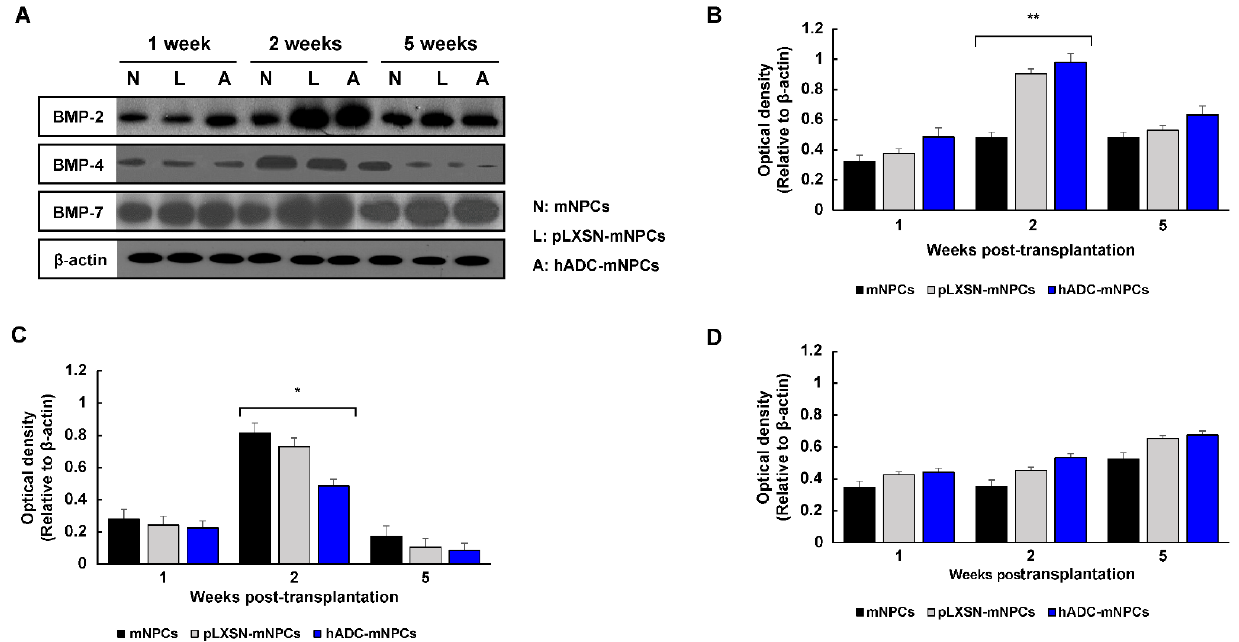
Figure 6. Western blot analysis of BMP-2, BMP-4, BMP-7, and β-actin from T8, T9, and T10 at 1, 2, and 5 weeks after cell transplantation. ( A ) Representative Western blots of BMP-2, BMP-4, BMP-7, and β-actin. ( B ) Quantification of BMP-2 showing a significant increase in hADC-mNPC mice compared with pLXSN-mNPC and mNPC mice at 2 weeks post-transplantation. ( C ) Quantification of BMP-4 showing a significant decrease in hADC-mNPC mice compared with pLXSN-mNPC and mNPC mice at 2 weeks post-transplantation. ( D ) Quantification of BMP-7 demonstrating a lack of significant difference across the three groups, despite slightly higher expression in the hADC-mNPC group at 1, 2 and 5 weeks post-transplantation. Data are presented as means ± SEM. ( n = 5 per sample, * p < 0.05, ** p < 0.01).